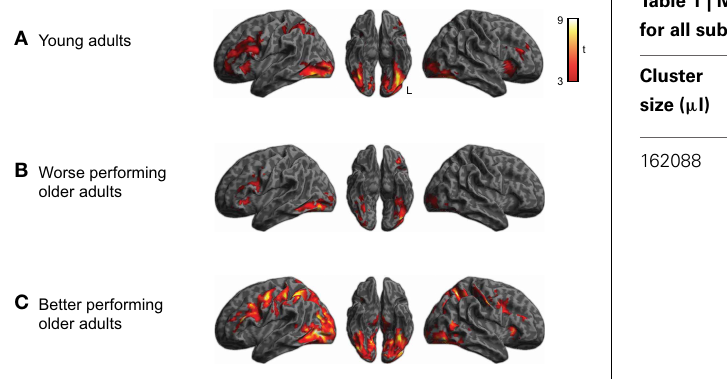
FIGURE 2 | Activation for performing semantic judgments (collapsed across category) relative to rest for each of the three subject groups (voxelwise p < 0 . 001, cluster-level corrected q < 0 . 05). (A) Activity for young adults. (B) Activity for worse-performing older adults. (C) Activity for better-performing older adults. Older adults were divided into groups based on median split performance of the behavioral data.